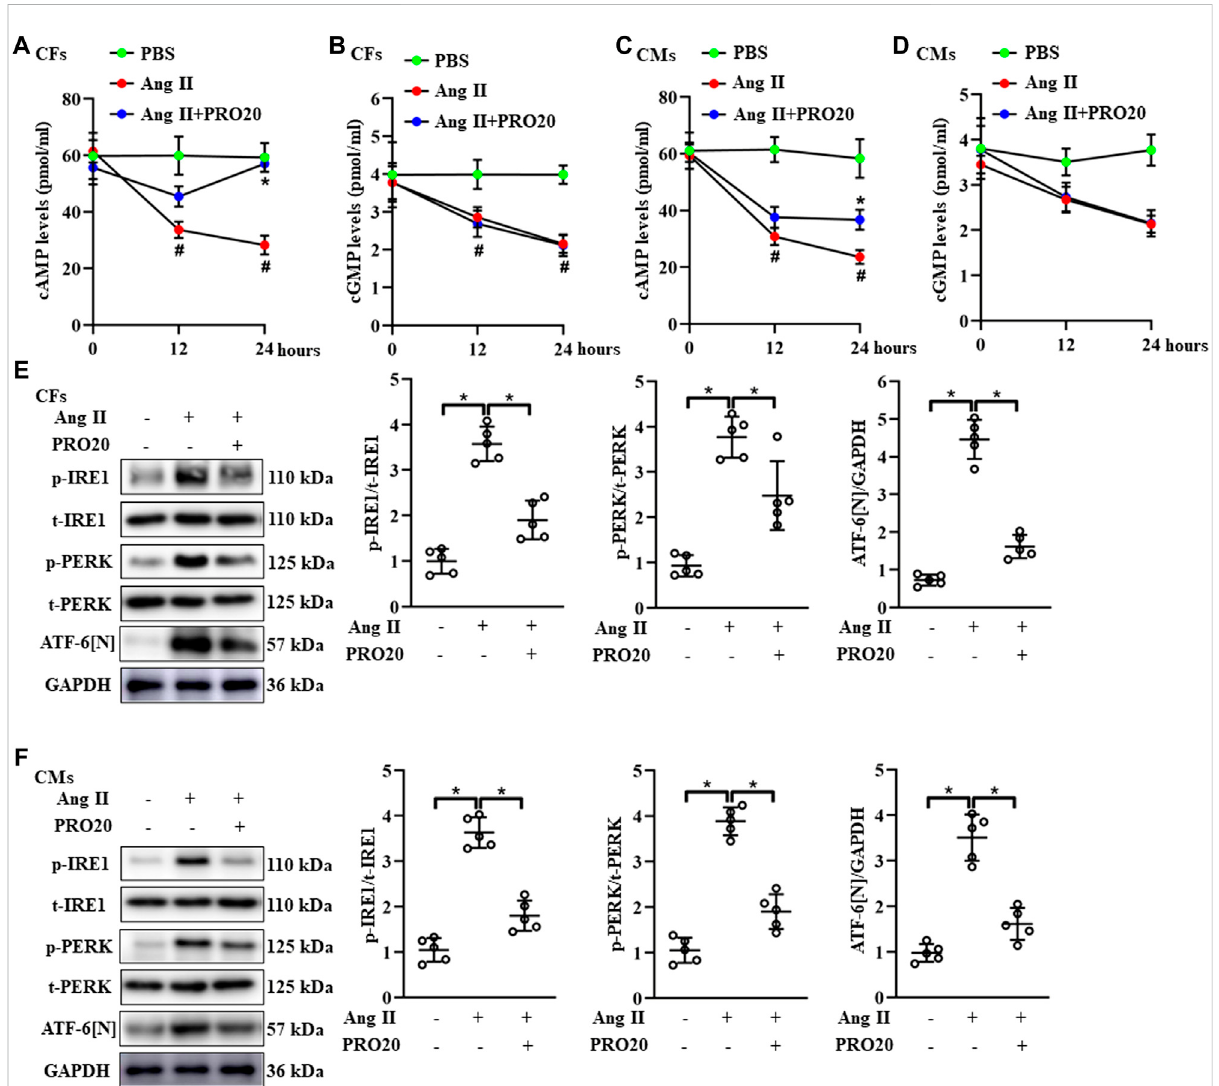
FIGURE 5 PRRdecoyinhibitorPRO20promotesintracellularcAMPcontentandsuppressesendoplasmicreticulumstress. (A – B) Theintracellularcontent of cAMP and cGMP in Ang II-induced CFs with and without PRO20 treatment (10 nM). # p < 0.05 vs. PBS group; p p -value < 0.05 vs. Ang II group at indicated time point. (C – D) The intracellular content of cAMP and cGMP in Ang II-induced CMs with and without PRO20 treatment (10 nM). # p < 0.05 vs. PBS group; p p -value < 0.05 vs. Ang II group at indicated time point. (E) Immunoblot analysis of IRE1, PERK and cleaved N-terminal cytoplasmic domain of ATF-6 (ATF-6 [N]) in Ang II-induced CFs and quantitative analysis of the IRE1 and PERK phosphorylation and the ATF-6